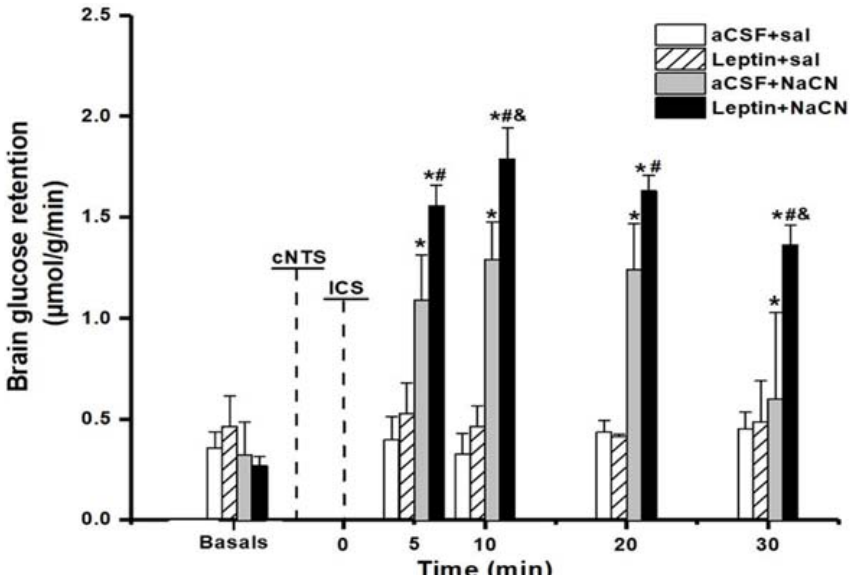
Figure 3. Rat brain glucose retention after leptin or control aCSF injections in the cNTS with NaCN or saline (Sal) in the ICS. The values are means ± SDM. * p < 0.05 vs. basal values; # p < 0.05 vs. leptin + saline; & p < 0.05 vs. aCSF + NaCN. ANOVA with Scheffé post hoc test. cNTS, injection into the commissural nucleus tractus solitarius of leptin or aCSF; ICS, injection into the isolated carotid sinus of NaCN or saline. aCSF, artificial cerebrospinal